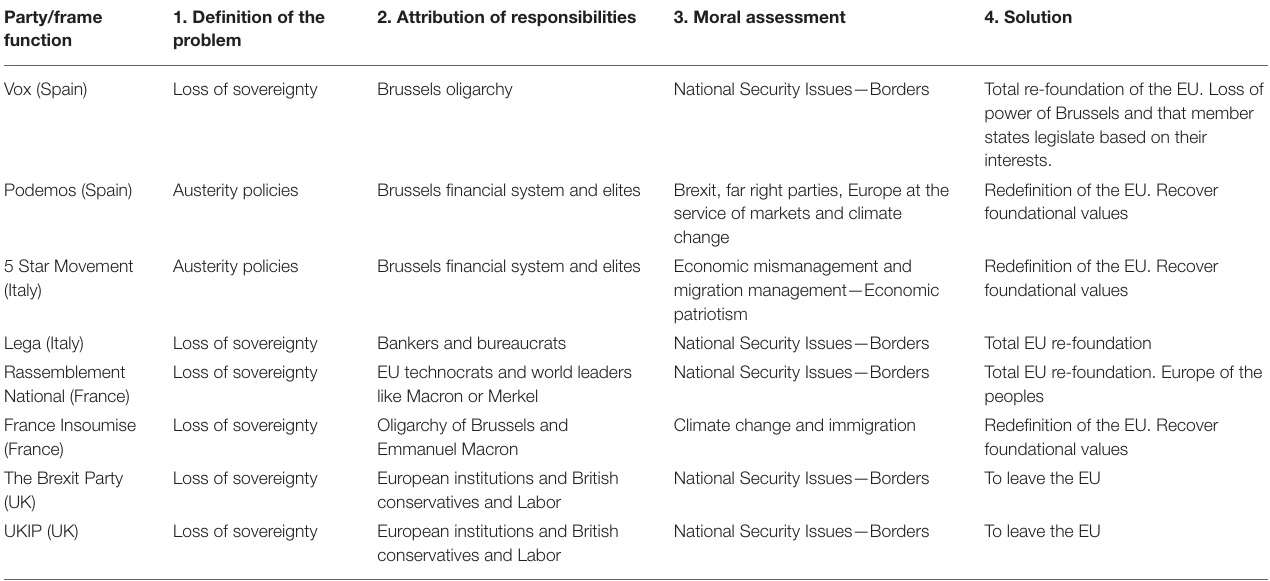
TABLE 2 | Summary of the main discursive axes of European populist parties. Party/frame